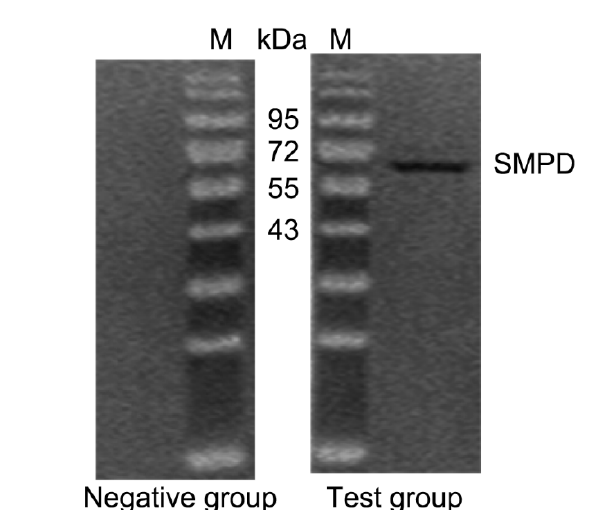
Fig 4 . Purified GST-SMPD protein separated in SDS-PAGE electrophoresis. M, protein molecular weight standards; lane1, recombinant protein was purified by gel isolation.